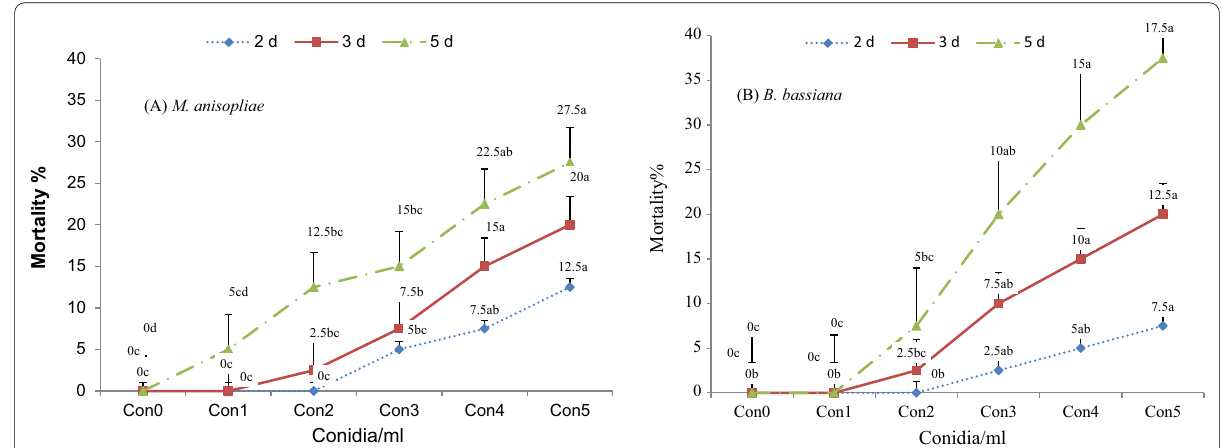
Fig. 1 Accumulated mortality percentages of Bactrocera zonata pupae at three time intervals, treated in the larval stage with different concentrations of Metarhizium anisopliae ( A ) and Beauveria bassiana ( B ) fungus under laboratory conditions. Concentrations on x‑axis represent Con0 Control, Con1 2.0 10 5 ‑, Con2 4.0 10 5 ‑, Con3 6.0 10 5 ‑, Con4 1.2 10 6 ‑, Con5 2.3 10 6 ‑Conidia/ml. Error bars indicate = = × = × = × = × = × the standard error; means sharing similar style letters do not significantly differ at a probability level of ±